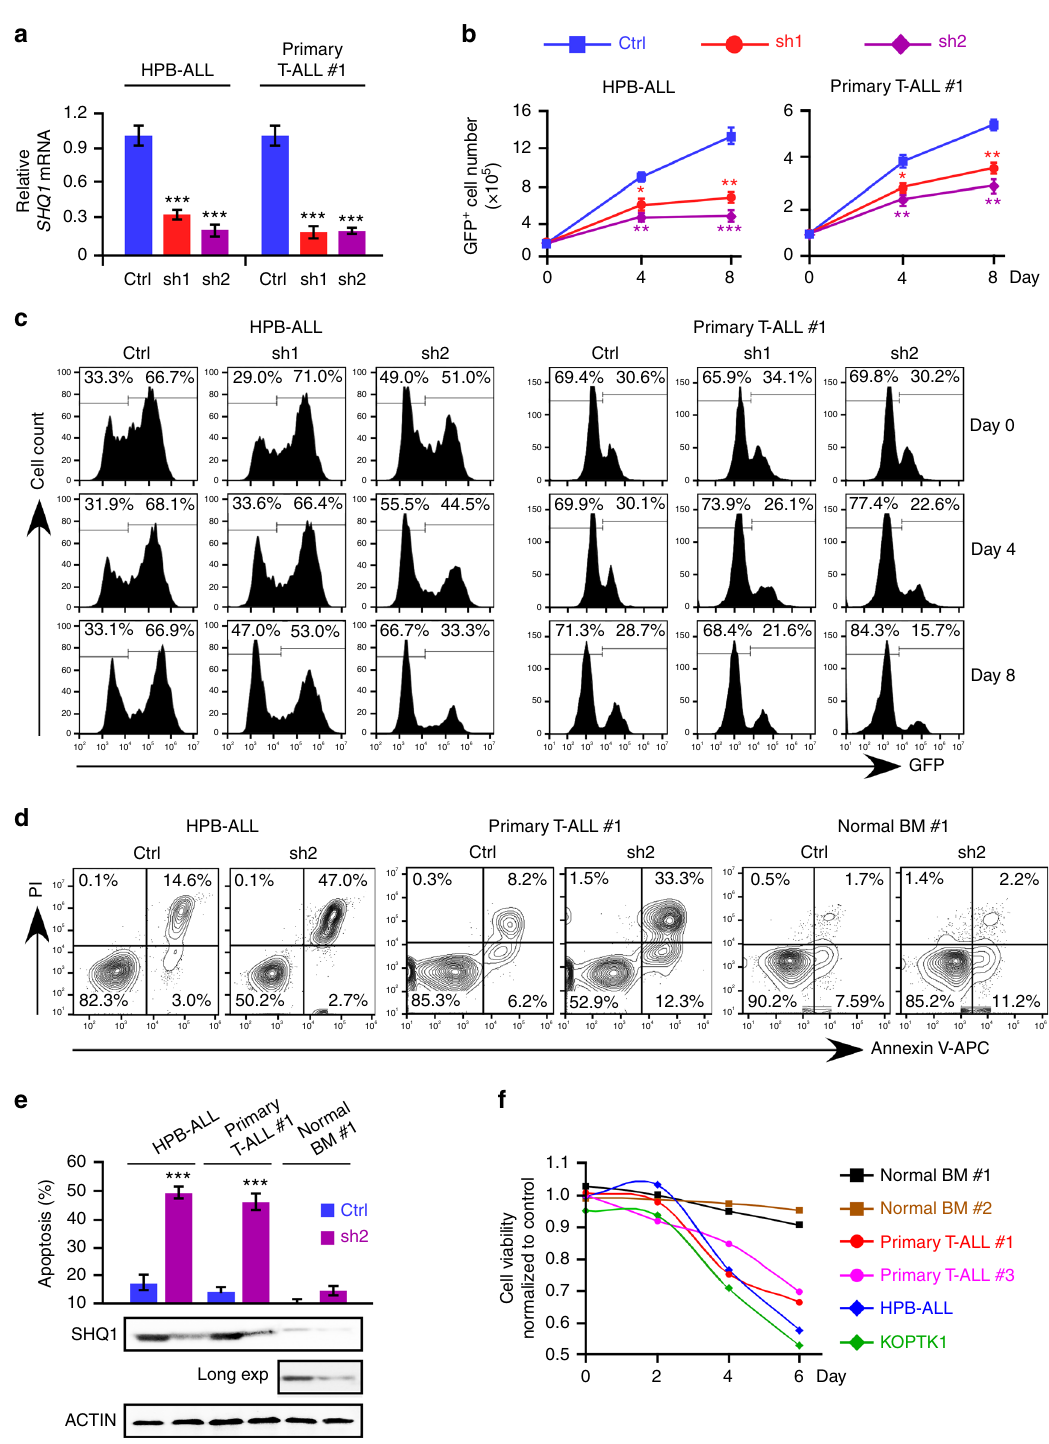
Fig. 3 SHQ1 depletion impairs T-ALL cell survival while it spares normal bone marrow cells. a HPB-ALL and patient-derived T-ALL (#1) cells were infected with lentiviruses expressing control (Ctrl, blue) or SHQ1 shRNA (sh1-red or sh2-purple) with GFP as an expression marker. SHQ1 mRNA levels were analyzed in GFP + cells. b Live GFP + cells were counted at the indicated time points and cell growth was plotted as shown. Cell counts of those expressing control shRNA, SHQ1 shRNA-1, or -2 are marked as blue square, red circle, or purple diamond. c Percentages of GFP + cell populations were analyzed by fl ow cytometry at the indicated time points post infection. d , e Apoptotic cell death was analyzed by Annexin V-PI staining 6 days post infection and quanti fi ed in e (blue: control shRNA, purple: SHQ1 shRNA-2), along with immunoblots of SHQ1. Long exposure of SHQ1 bands in bone marrow cells is also shown (Long exp). f Cell viability was assessed by MTT assay in two T-ALL cell lines (HPB-ALL, blue and KOPTK1, green), two primary T-ALL cells (#1, red and #3, purple), and two normal human BM cells (#1, black and #2, brown) expressing either control or SHQ1 shRNA. Absorbance readings of SHQ1 -de fi cient cells relative to control cells were plotted as shown. Data shown represent the means (±SEM) of three biological replicates; * p < 0.05, ** p < 0.01, *** p < 0.001, unpaired t -test ( a , b , e